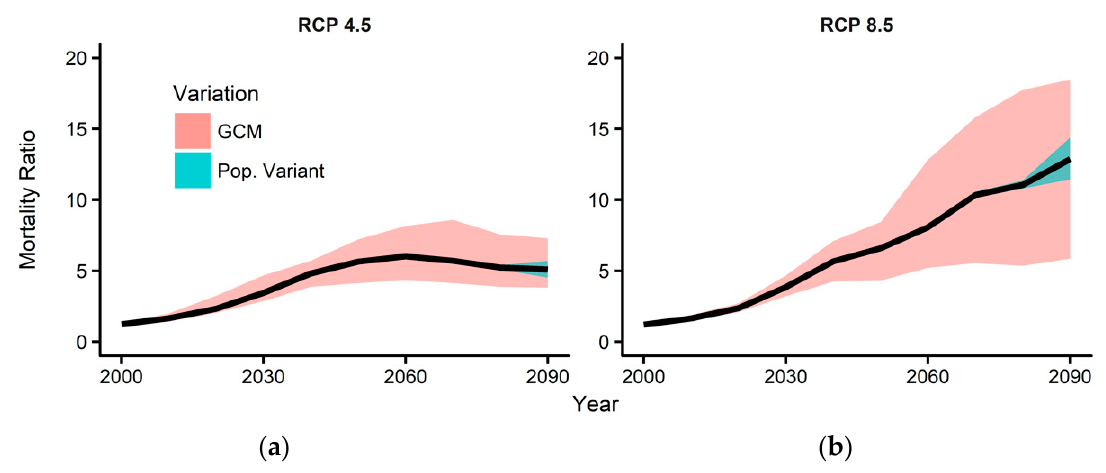
Figure 3 . Projections of summer temperature-attributable mortality ratio (MR) associated with climate and population changes from 2000 to 2100 under ( a ) RCP 4.5 and ( b ) 8.5. The red and blue shaded areas show the variations in the MR projections due to uncertainties in climate and population changes, respectively.